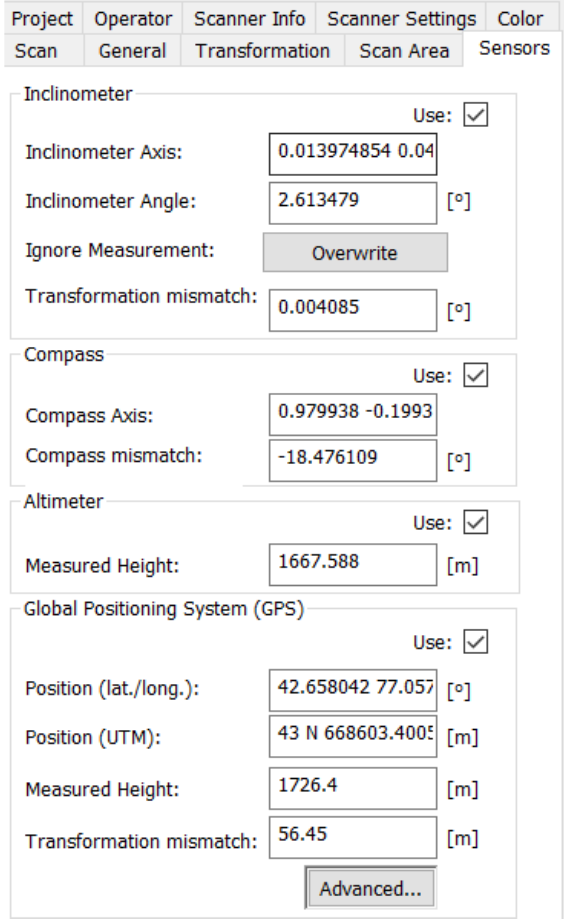
Figure 4. Sensor panel of the FARO Focus TLS.